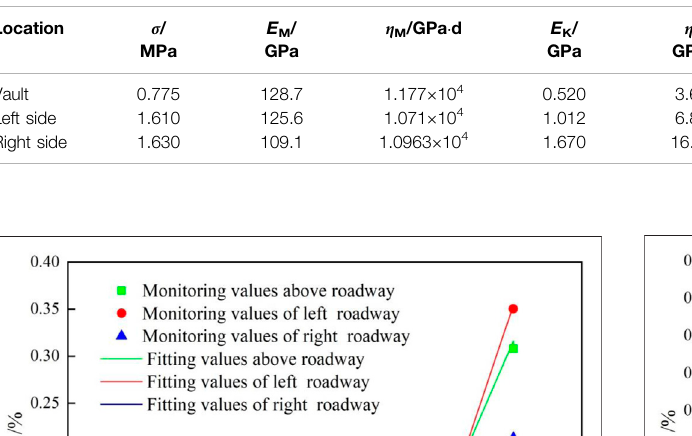
TABLE 4 | Fitting parameters of Formulas 3 and 4 under the dry state.